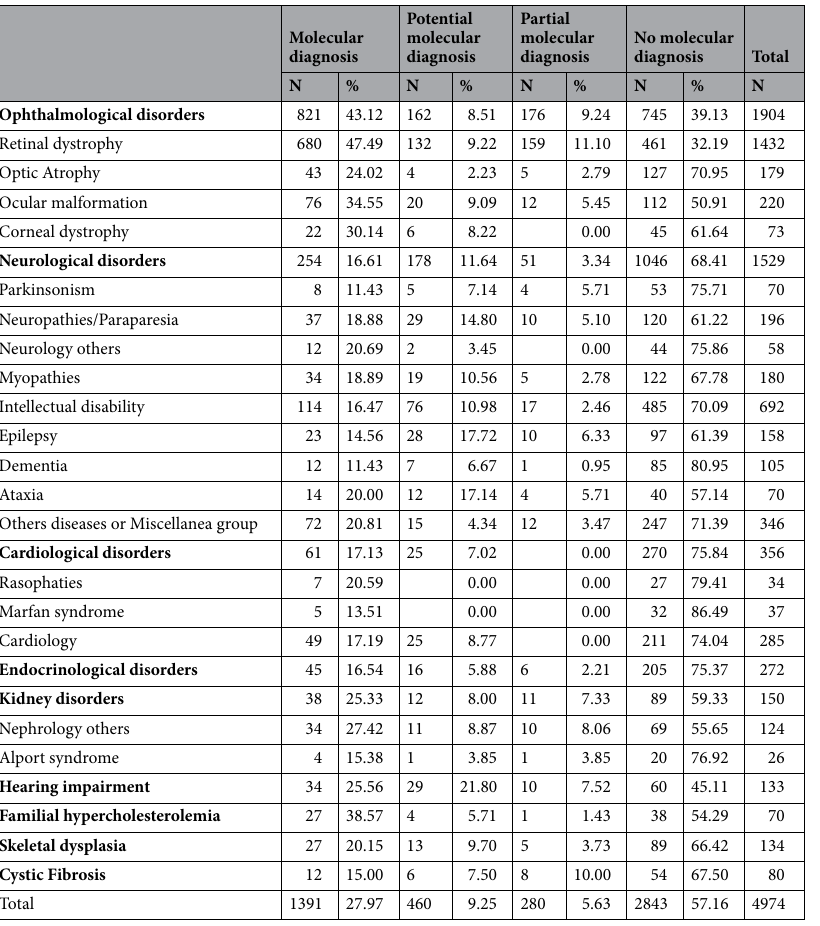
Table 2. Molecular, potential molecular, partial molecular and no molecular diagnosis cases of each group of diseases. Molecular diagnosis cases were used to establish the DR among each group and subgroup of disease. Data are ordered from highest to lowest according to the number of molecular diagnosis cases. Solved cases correspond to potential and molecular diagnosis